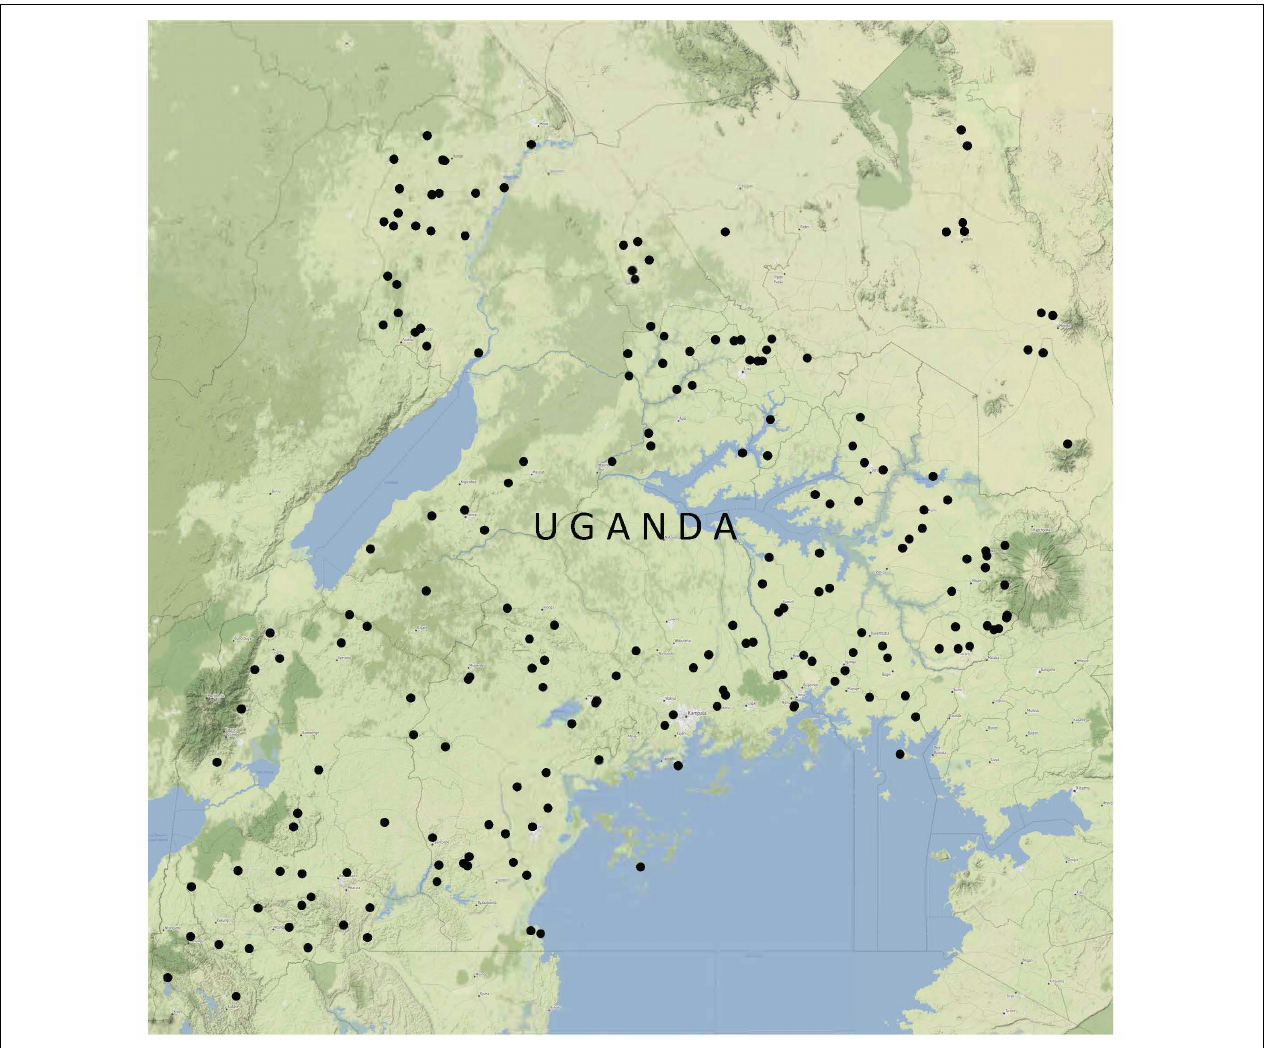
FIGURE 1 | Spatial distribution of study households across Uganda. This figure shows the public coordinates of household clusters used in our sample of 1,395 rural households in Uganda (to protect confidentiality, household location coordinates in the data are not exact, but rather based on a random distortion of 0–5 km). Data source: UNPS 2005–2006, 2010-2011, and